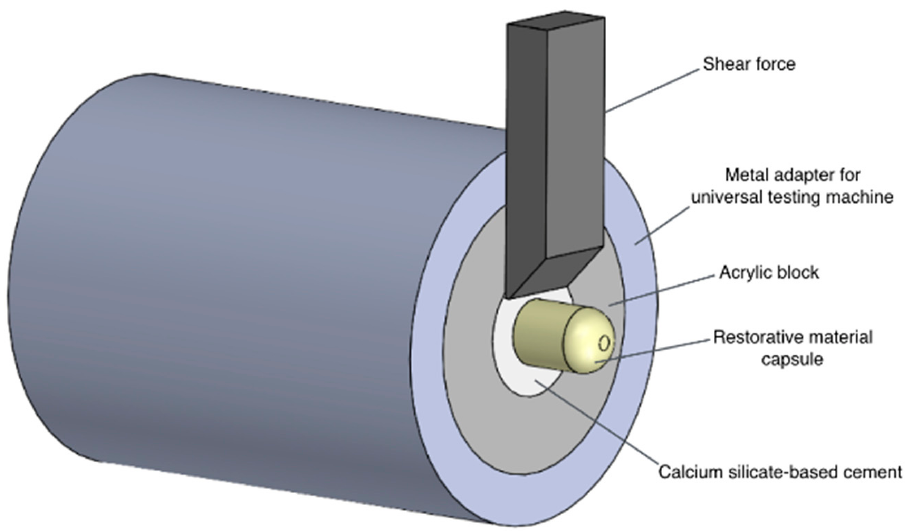
Figure 1. Schematic illustration of sample design and positioning during shear bond strength test.